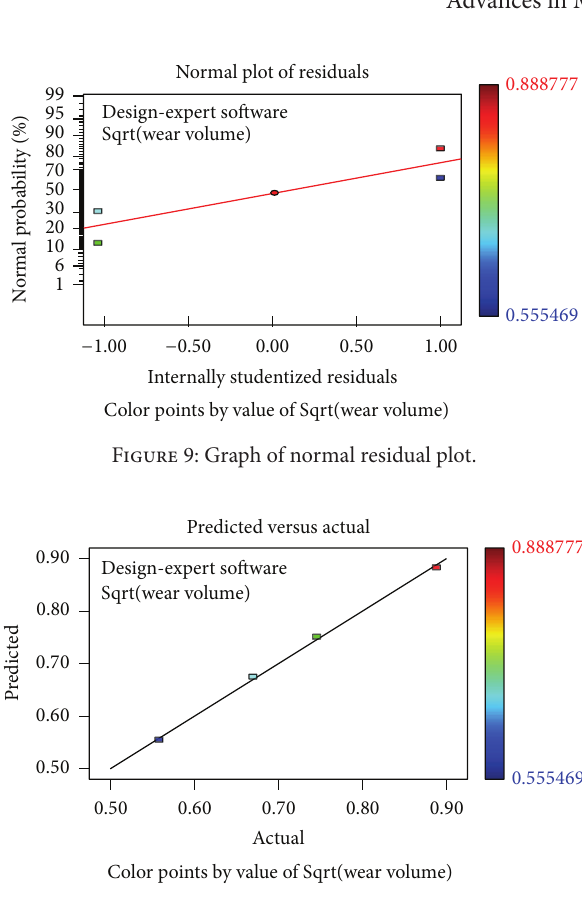
Figure 10: Graph of predicted versus actual experimental